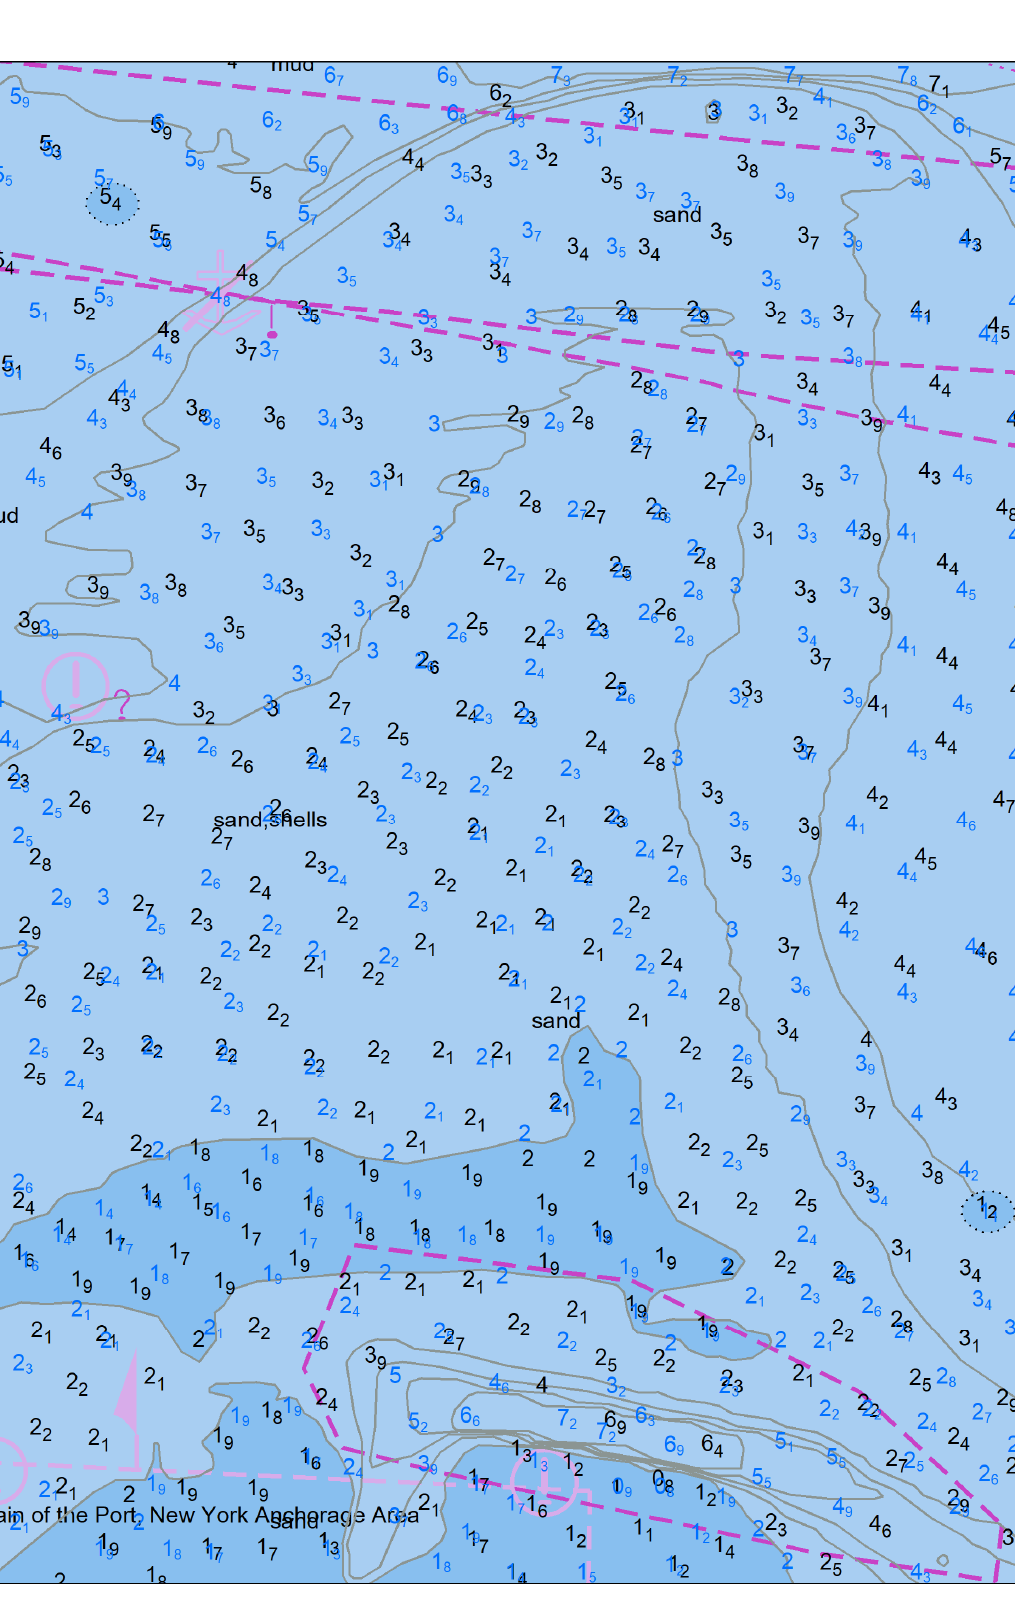
Figure 13. Soundings at 1:10 K scale (in blue) are overlaid to an extract of NOAA ENC US5NYCAE (soundings in black).